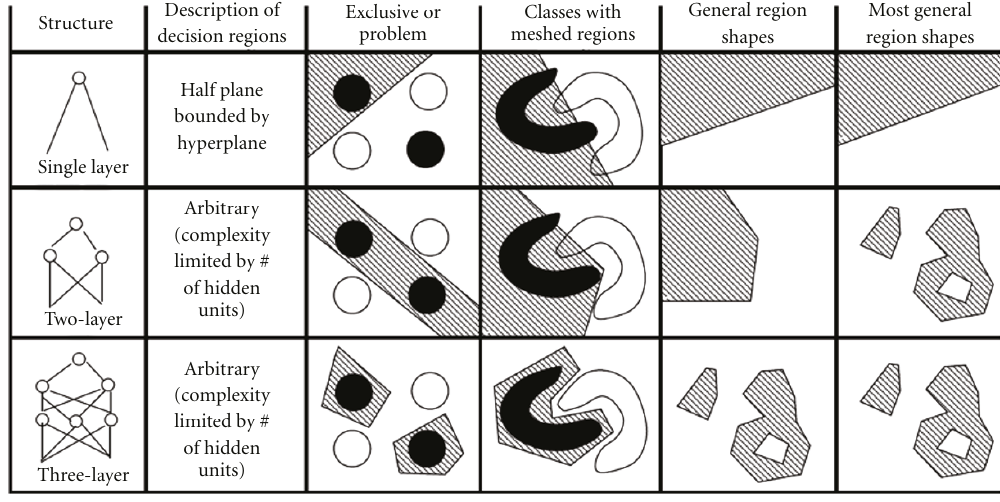
Figure 2: Classification interpretation of ANN model selecyion [51].